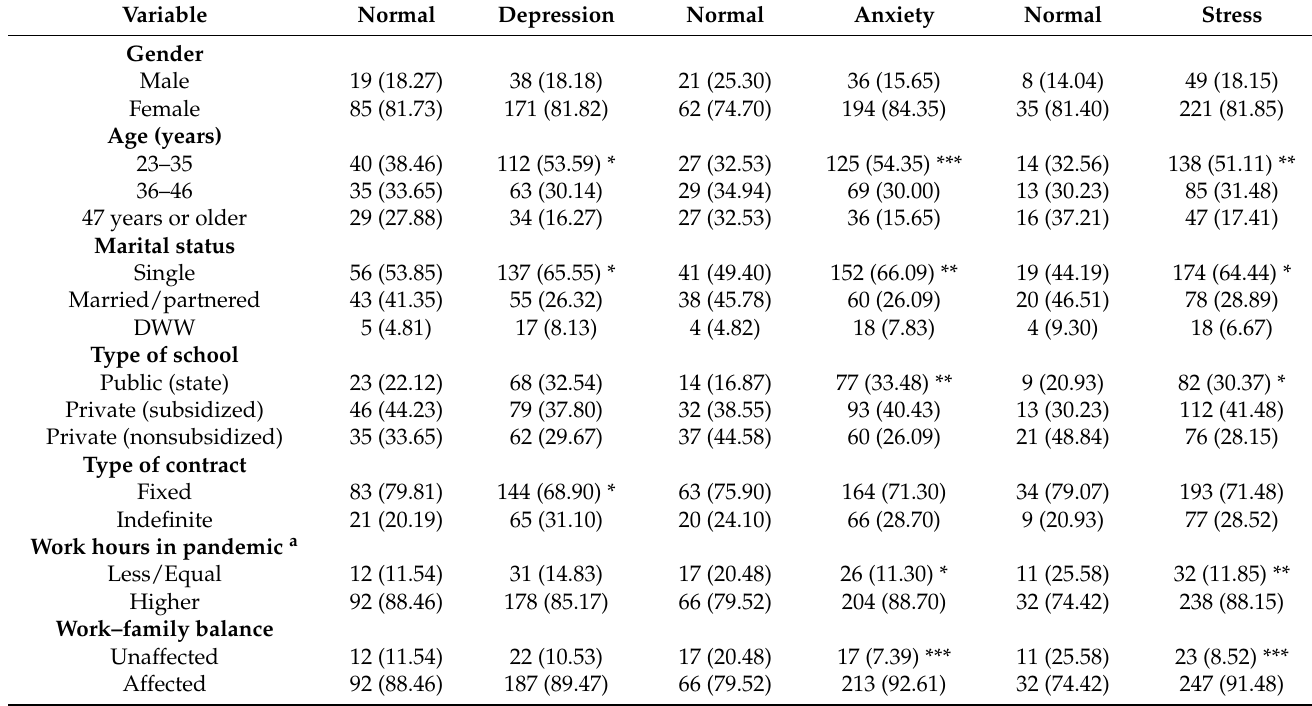
Table 5. Sociodemographic and socio-personal features of Chilean teachers according to the presence or absence of